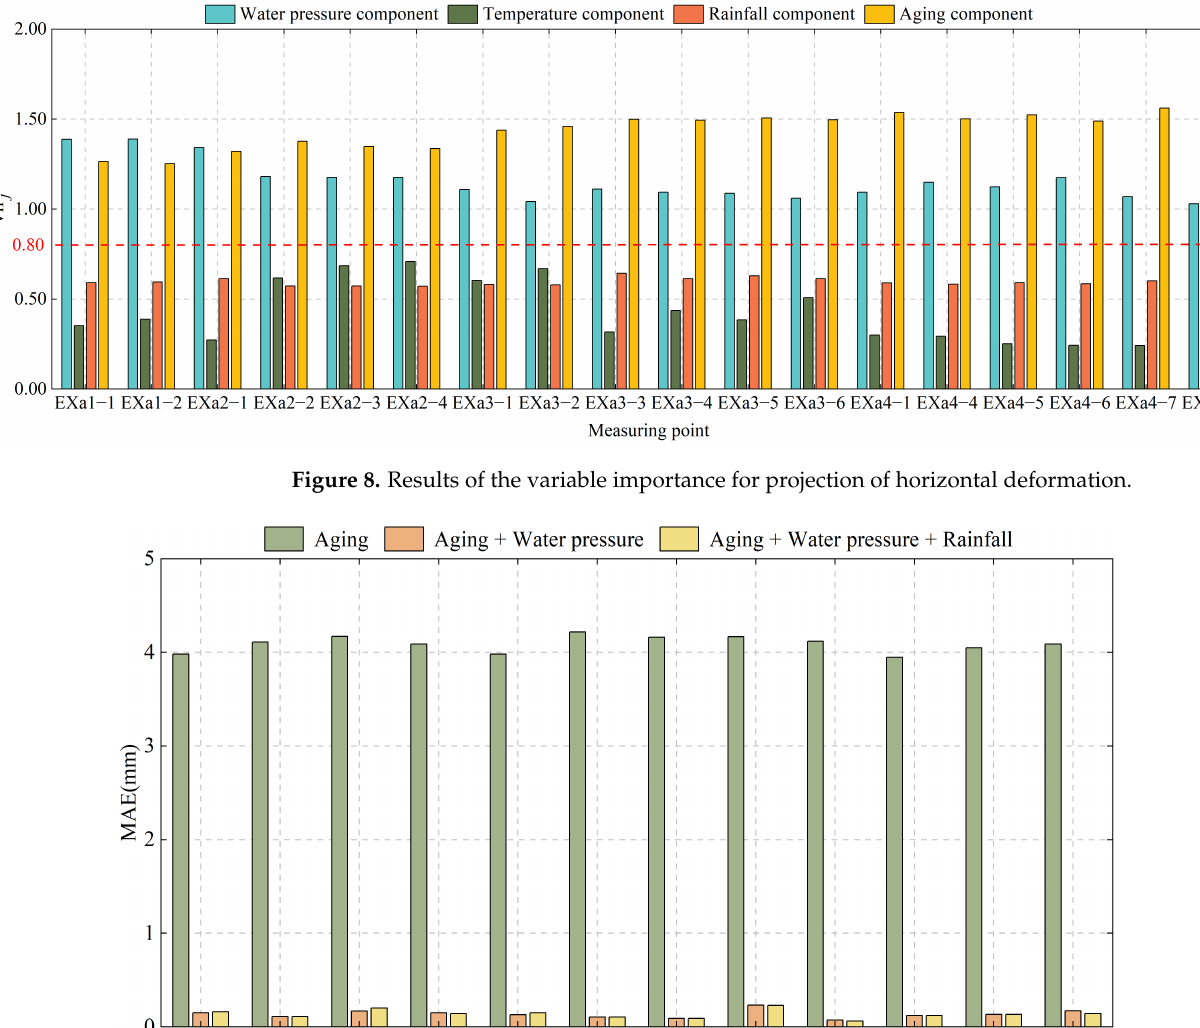
Table 2. Spatial repair results with selection of different covariates of the two–dimensional model.